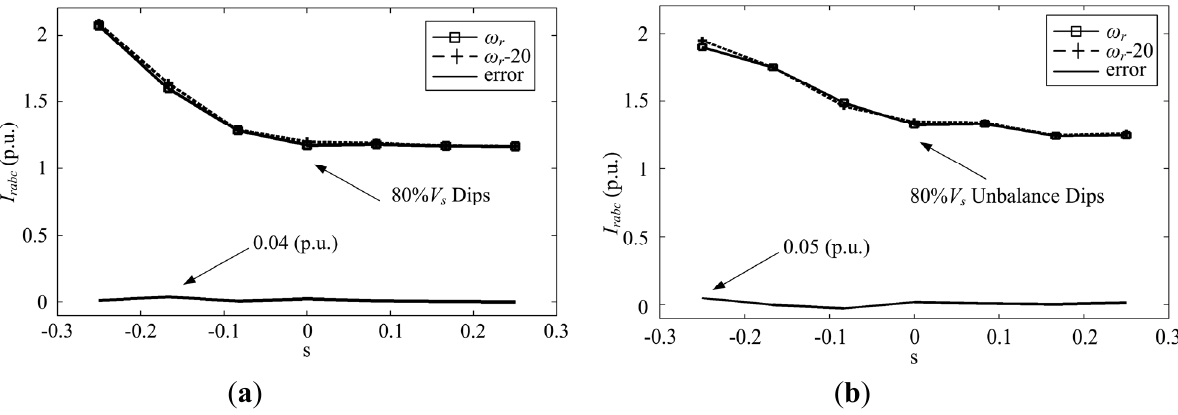
Figure 15. The effect of detection signal on the peak of rotor current. ( a ) 80% three-phase- to-ground fault; ( b ) 80% phase-phase-to-ground